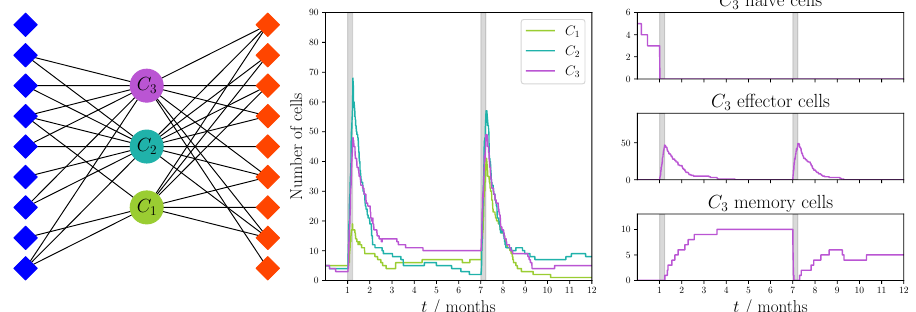
Figure 12. Single realization of an immune response to two viral challenges with a focused prefer- ential attachment recognition network and dynamics defined in Section 5.1. The network was con- structed using the sampling strategy described in Section 4.1.2 with probability of success p = 8/18. Blue diamonds represent VDPs present during the first viral challenge and red diamonds represent those present during the second challenge. We note that not every VDP was recognized by the clonotypes. Model parameters are described in Table 2. The python code used to generate this figure has been made available at https://doi.org/10.5281/zenodo.5227343